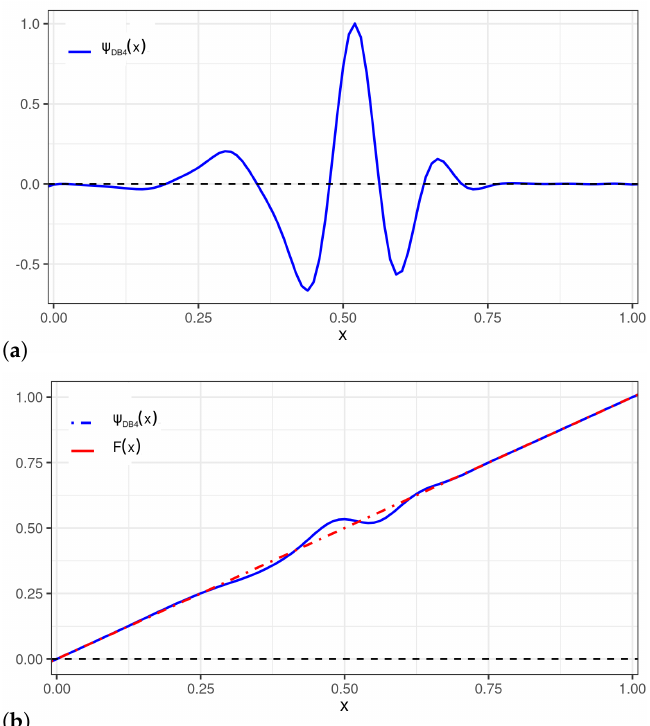
Figure 4. Plots of: ( a ) a DB4 wavelet perturbation to be applied to the U [ 0,1 ] distribution; and ( b ) DB4 wavelet perturbation (— blue) and uniform (- · - red)